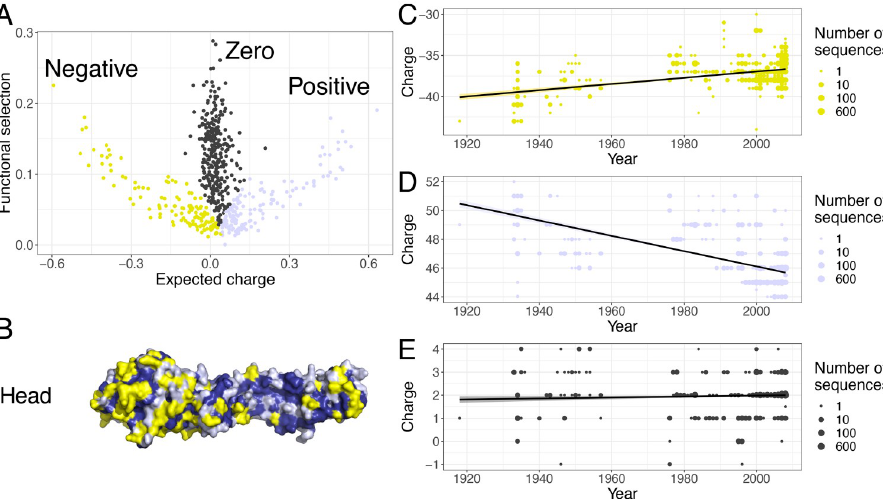
Fig 2. Identification of negative, zero, and positive functional branches. ( A ) Scatter-plot of site-wise functional selection and expected charge, based on deep mutational scanning (DMS). For a given residue using DMS preference data, ‘functional selection’ is a measure of functional constraints at this site (a transformation of Shannon’s evenness) and ‘expected charge’ is the mean charge from DMS preferences. The colours are to facilitate the identification of the negative (yellow), zero (dark blue), and positive (light blue) branches. ( B ) The location of the residues belonging to each of the three branches identified in A , on the HA monomer, visualized with PyMOL [24] and PDB 1RVX [23]. (C)- (E) The net charge of the positive ( C ), negative ( D ), and zero ( E ) branches over time in 1741 H1N1 sequences from human hosts during 1918 to 2008.